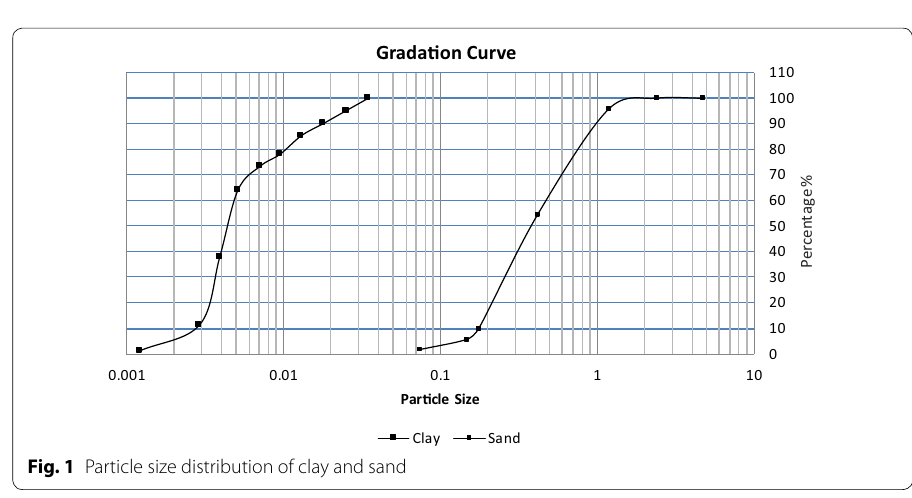
Fig. 1 Particle size distribution of clay and sand